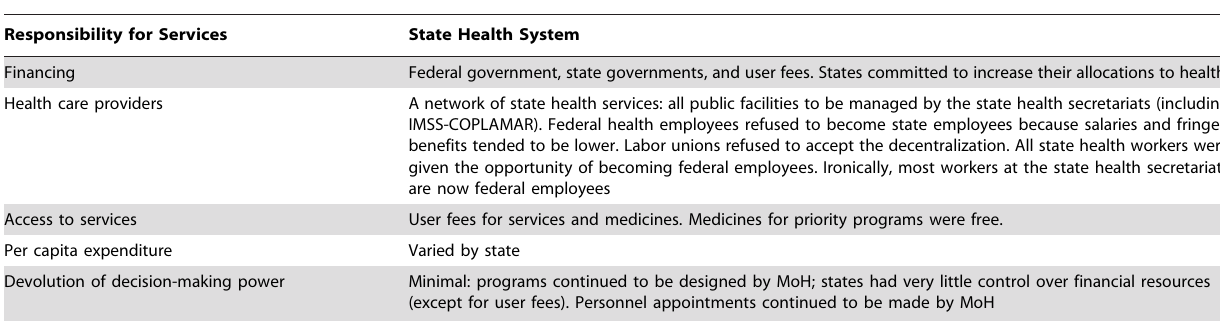
Table 3. Organization of health care for the uninsured in the 14 decentralized states (1984–1994).